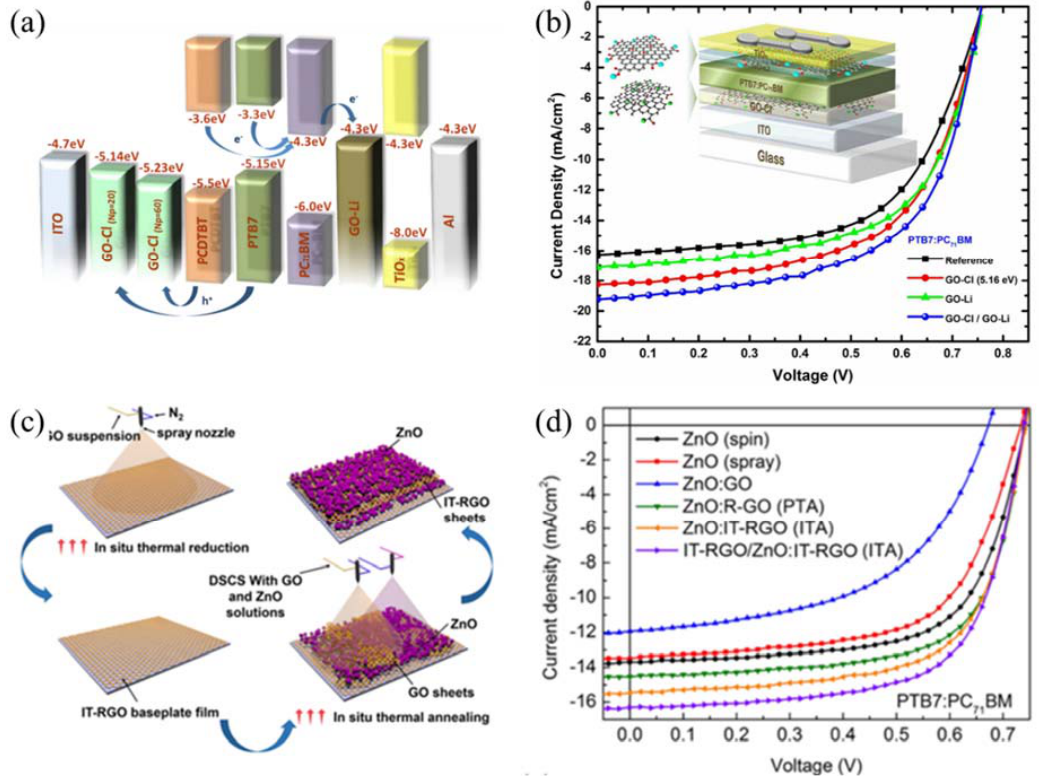
Figure 9. ( a ) Energy band structure of the OSCs with the incorporation of GO-Cl and GO-Li; ( b ) the architectures of OPVs based on PTB7:PC 71 BM and the J-V characteristics of the device; ( c ) the fabrication process of ZnO:IT-RGO hybrid ETL; ( d ) the J-V characteristics of OSCs based on different hybrid ETLs. Reprinted with permission form [94,95]. Copyright 2016 The Royal Society of Chemistry and 2017 American Chemical Society.